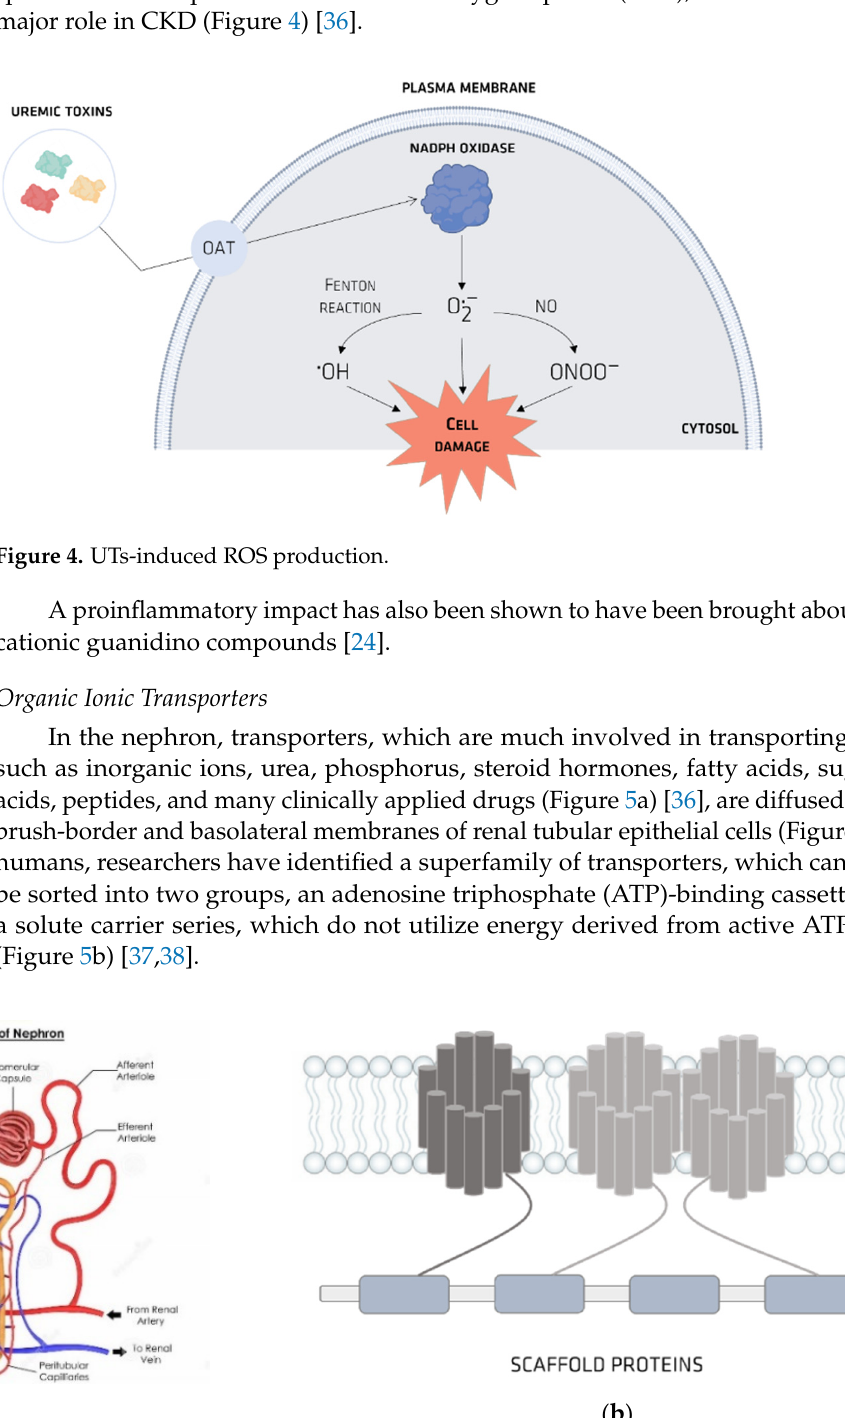
Figure 5. ( a ) nephron structure; ( b ) organic anionic transporter’s structure.